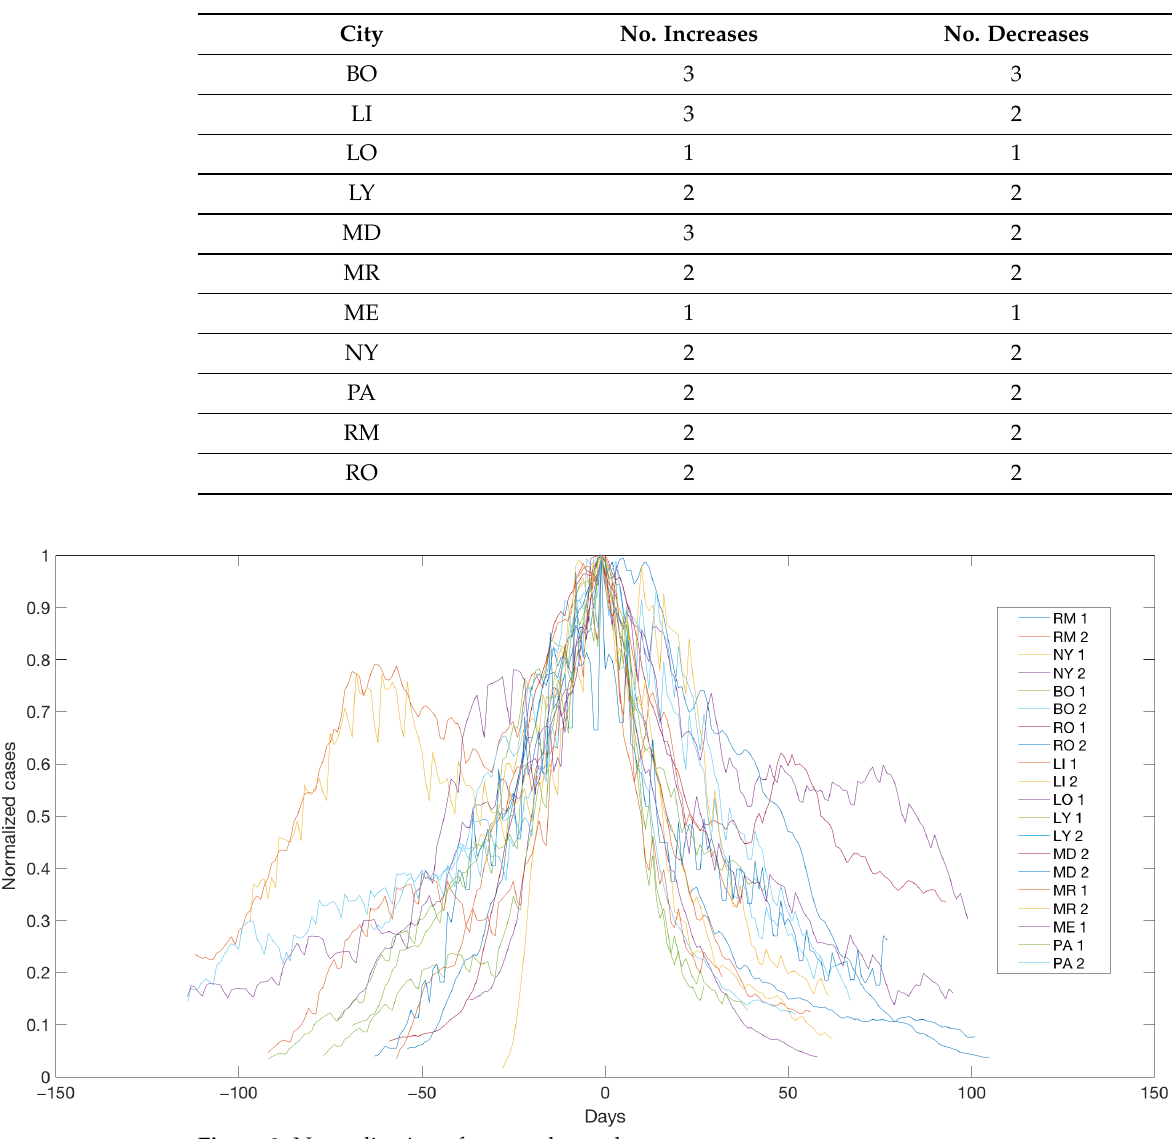
Table 2. Numbers of rises and drops for the eleven cities.